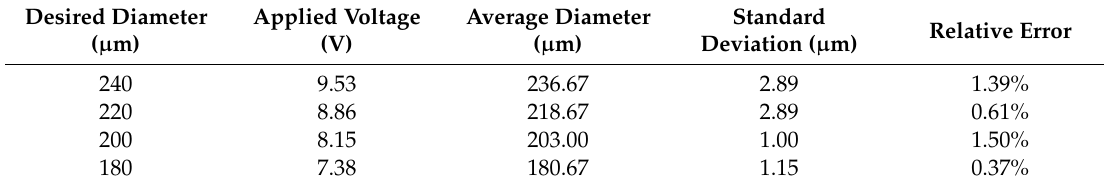
Figure 9. Shape of holes with different diameters: ( a ) 240 μ m; ( b ) 220 μ m; ( c ) 200 μ m; ( d ) 180 μ m. Table 4. Results of fabricated holes of different diameters.